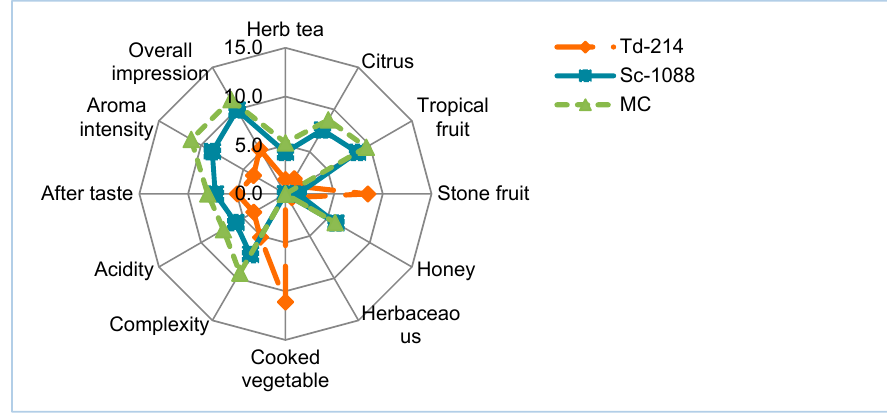
Figure 3. Sensory analysis of Narince wines produced in the pure and mixed culture. Td-214: T. delbrueckii -214, Sc-1088: S. cerevisiae -1088, MC: Mixed culture of T. delbrueckii -214 and S.cerevisiae- 1088.